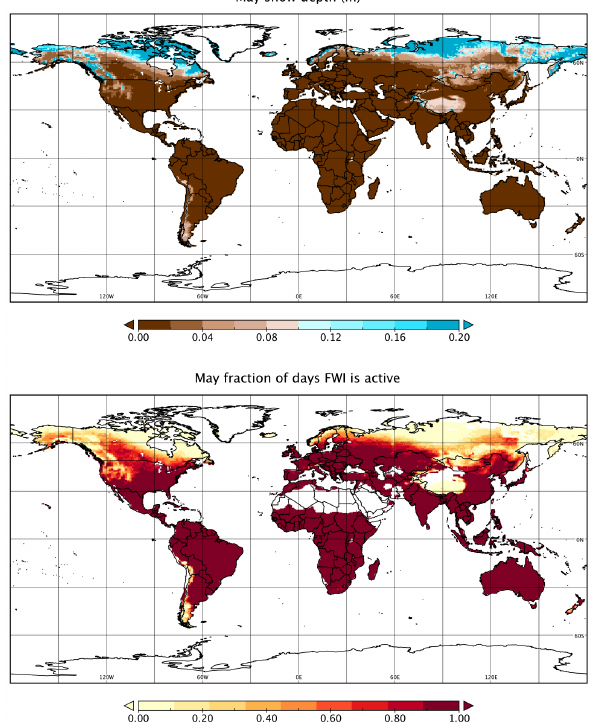
Figure 1. Mean MERRA snow depth (top) and fraction of active FWI calculation days (bottom) for May, 1980–2012. The fraction of active FWI calculation days refers to the number of days in May where DC calculations are not shut down due to cold conditions or snow